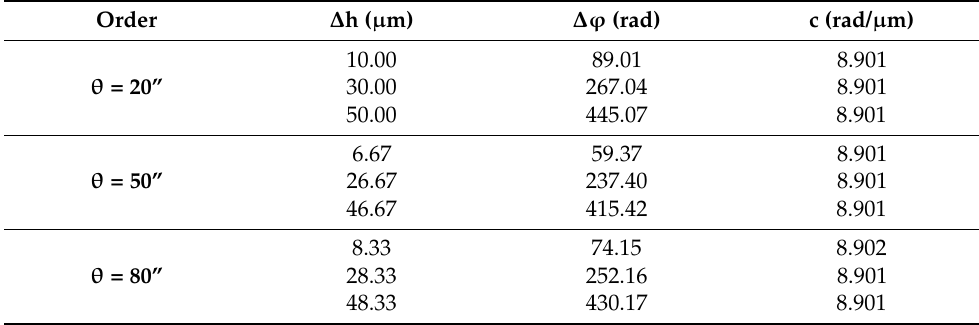
Table 1. Calibration results of the linear coefficient c.